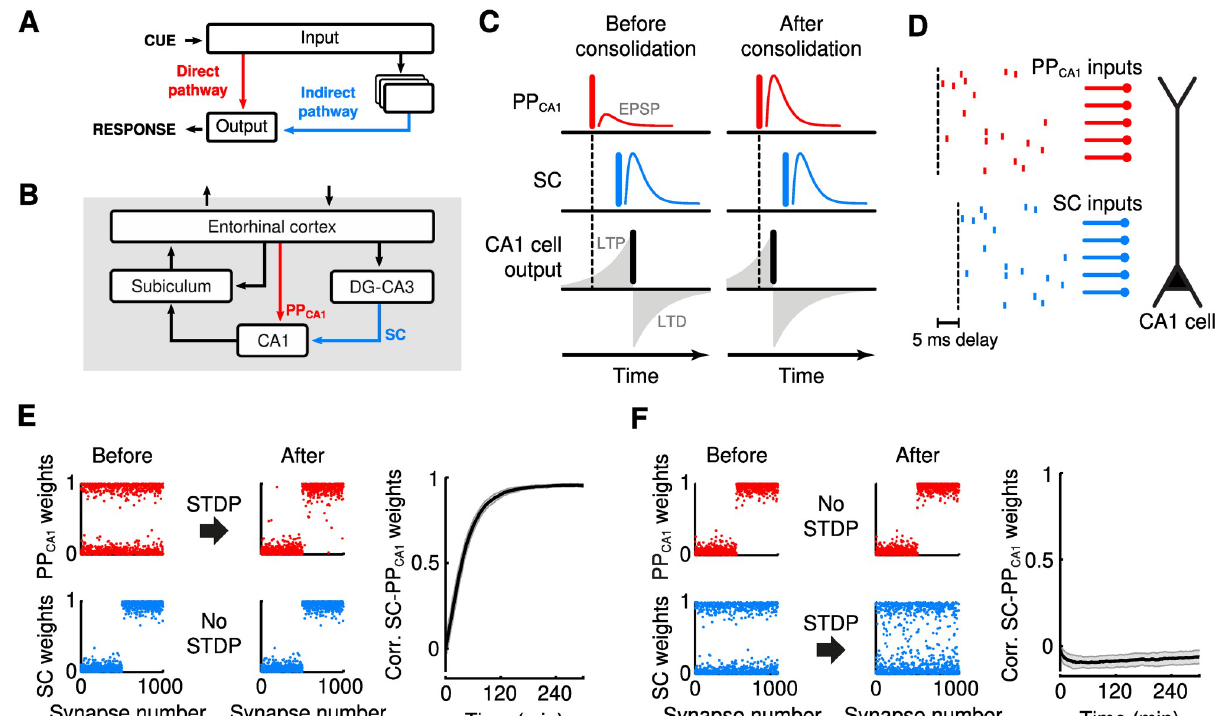
Fig 1. A mechanistic basis for systems memory consolidation. (A) Circuit motif for the parallel pathway theory. Cue-response associations are initially stored in an indirect synaptic pathway (blue) and consolidated into a parallel direct pathway (red). (B) Hippocampal connectivity. The entorhinal cortex projects to CA1 through an indirect pathway via DG-CA3 and the Schaffer collaterals (SC, blue arrow), and through the direct perforant path (PP CA1 , red arrow). (C) Model of consolidation through STDP. Left: before consolidation, a strong SC input (middle, blue vertical bar) causes a large EPSP and triggers a spike in CA1 (bottom, black vertical bar). A weak PP CA1 input (top, red) that precedes the SC input is potentiated by STDP. Right: after consolidation through STDP, the PP CA1 input (top) can trigger a spike in CA1 by itself (bottom). (D-E) Consolidation in a single integrate-and-fire CA1 cell receiving 1000 PP CA1 and 1000 SC excitatory inputs. (D) PP CA1 activity consists of independent poisson spike trains; the SC activity is an exact copy of the PP CA1 activity, delayed by 5 ms. (E) Consolidation of a synaptic weight pattern from non-plastic SC synapses to plastic PP CA1 synapses. Left and middle: normalized synaptic weights before and after consolidation. Right: time course of correlation between SC and PP CA1 weight vectors during consolidation (mean ± SEM for 10 trials). (F) Failure of consolidation of a synaptic weight pattern from non-plastic PP CA1 to plastic SC synapses; panels as in